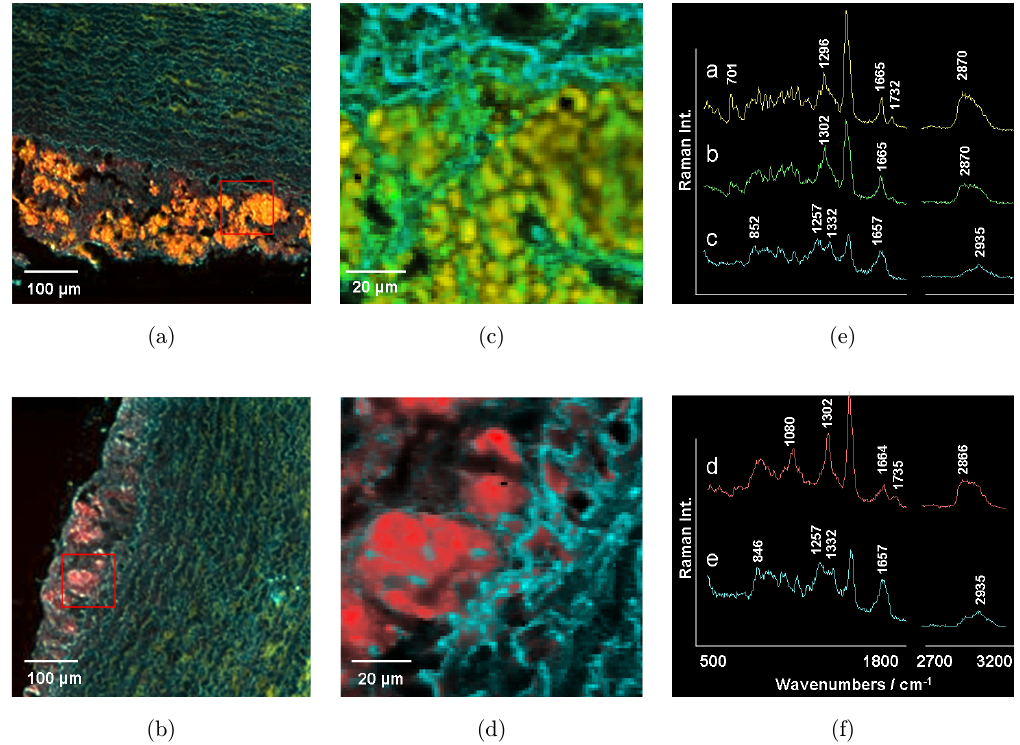
Fig. 2. Multimodal images of CARS (red), TPF (cyan) and SHG (yellow) signals of the two areas marked (I) and (II) in Fig. 1 and Raman images (c) and (d) of the indicated areas along with the associated spectral information plotted in (e) and (f). Within the Raman images, the spectra and the associated distribution of cholesterol esters are shown in yellow (a), cholesterol in green (b) and triglycerides in red (d). The surrounding connective tissue is plotted in cyan [(c) and